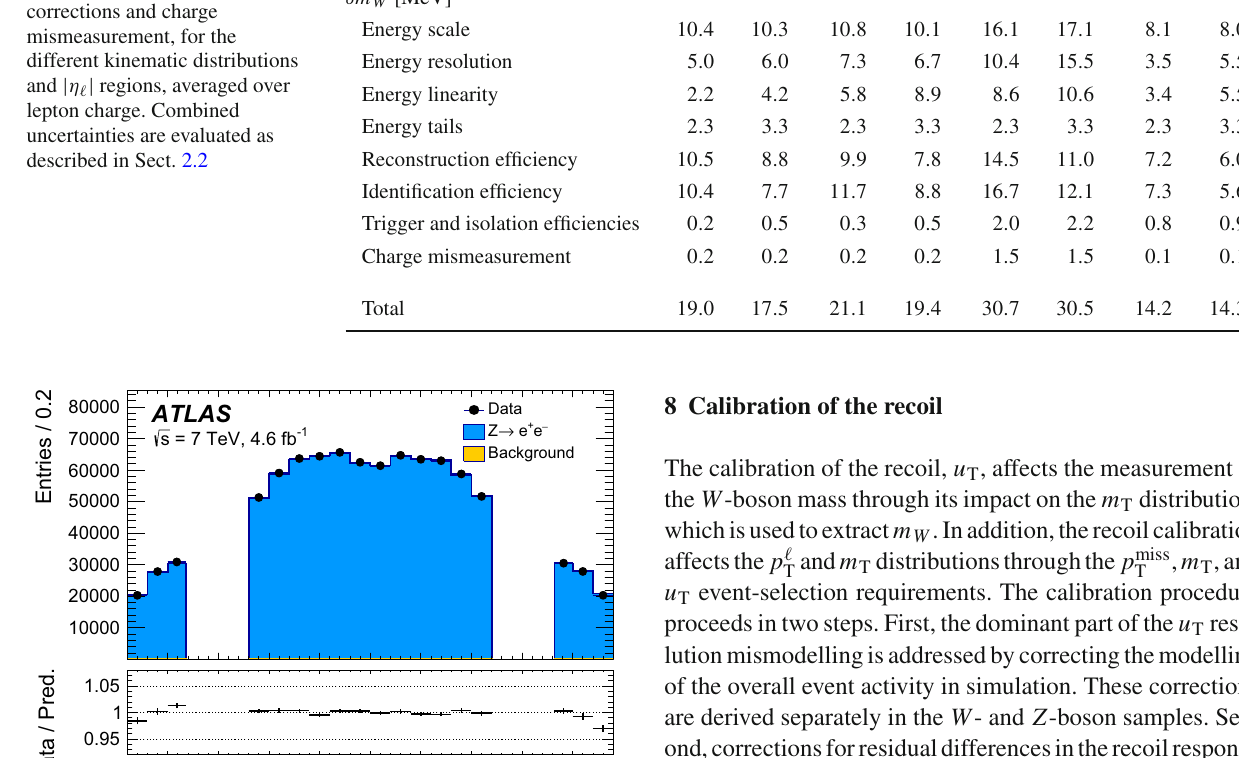
uncertainties in the m W measurement due to electron energy calibration, efficiency corrections and charge mismeasurement, for the different kinematic distributions and | η (cid:7) | regions, averaged over lepton charge. Combined uncertainties are evaluated as described in Sect. 2.2